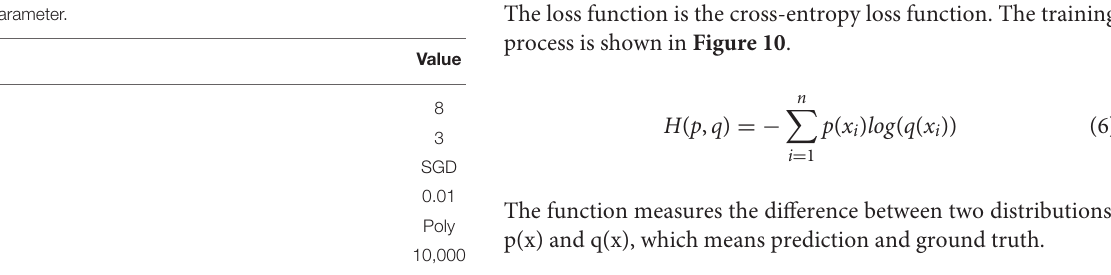
FIGURE 9 | Data augmentation. (A) Image inversion, (B) Image panning, and (C) Random crop. TABLE 1 |